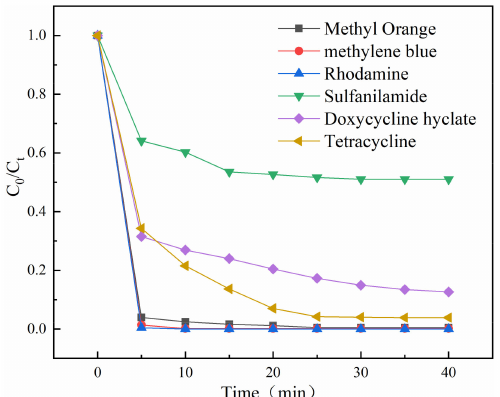
Figure 13. The degradation efficiency of CoFe 2 O 4 @CNTs/PMS system for different pollutants. (Exper- imental conditions: initial concentration of methyl orange, methylene blue, rhodamine, sulfanilamide, doxycycline hyclate, tetracycline = 20, 20, 20, 10, 10, 10 mg/L, PMS = 2 mM, catalyst = 35 mg/L, T = 25 ◦